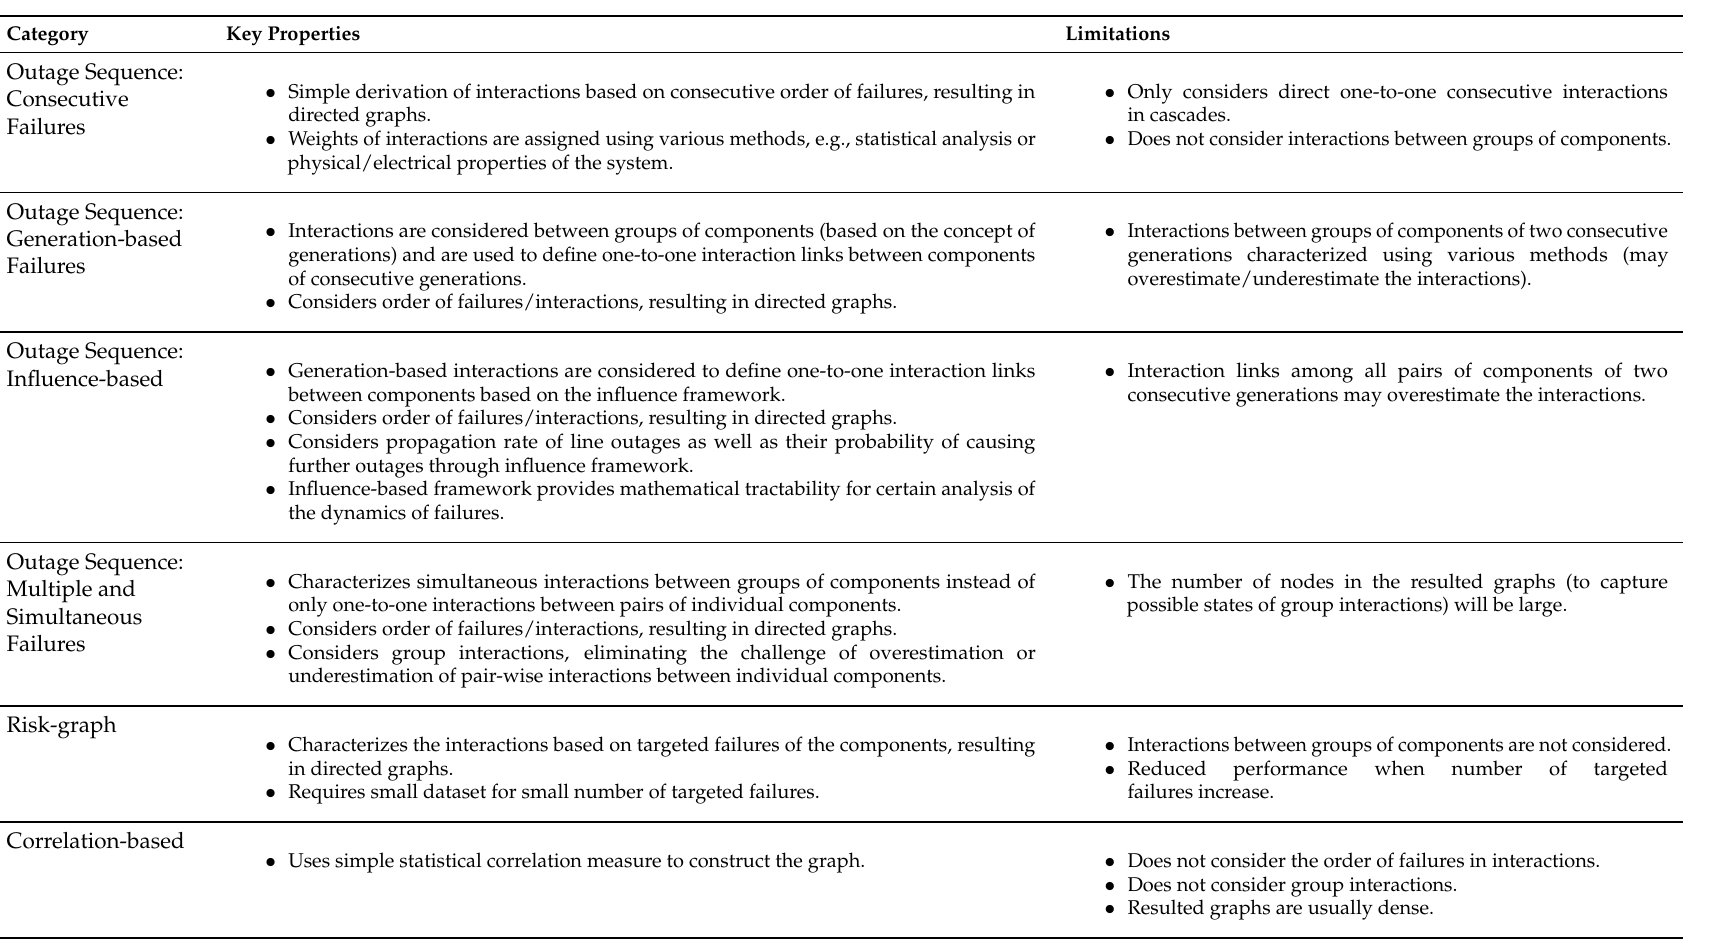
Table 2. Key properties and limitations of the methods for building data-driven interaction